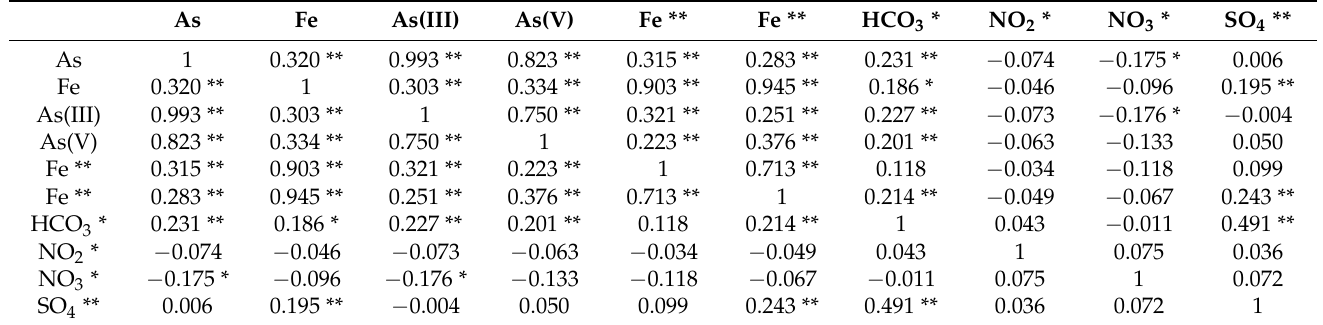
Table 8. Pearson correlation analysis between As and the main redox ions in the Southern Plain of the Yellow River ( n =